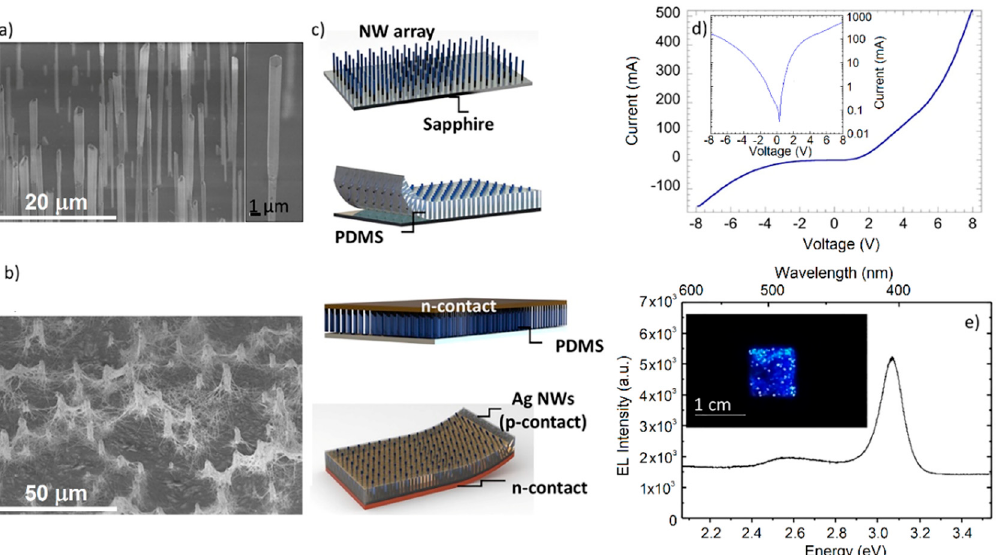
Figure 1. ( a ) SEM image of as-grown sample (inset shows close-up on individual nanowire (NW)); ( b ) SEM image of top contact with protruding InGaN/GaN NWs presenting good coverage by Ag nanowires; ( c ) schematic illustration of main fabrication steps (from top to bottom): as-grown NWs, peel-off of polydimethylsiloxane (PDMS)/NW composite membrane, deposition of bottom metal contact, fully processed light-emitting diode (LED) with top transparent contact; ( d ) current–voltage (I–V) curve of flexible LED. Inset shows I–V curve in logarithmic scale; ( e ) electroluminescence (EL) spectrum under 300 mA injected current. Inset shows photo of LED under operation.